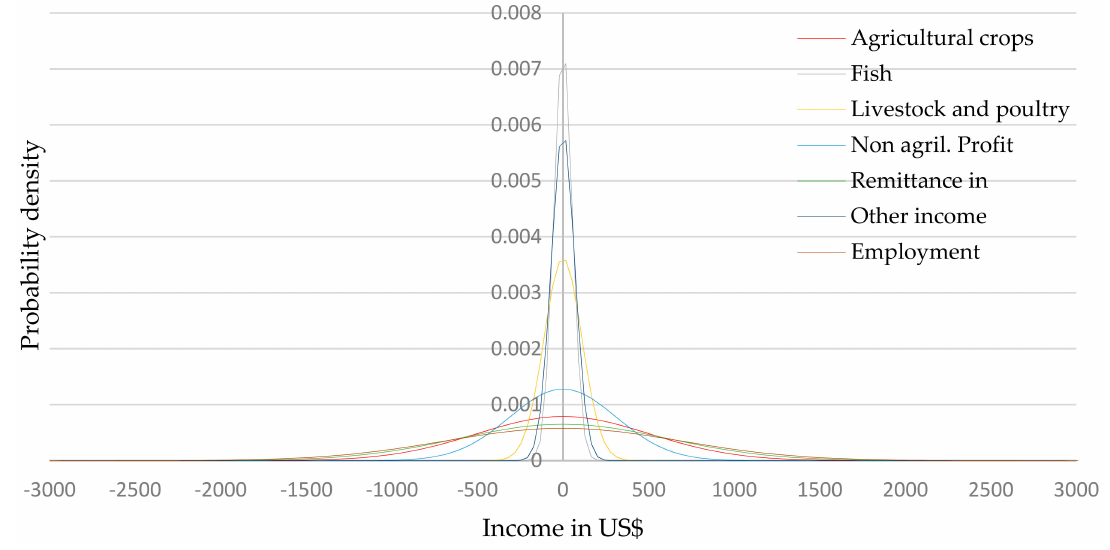
Figure 6. Distribution of total income (US$) for farm households in Rangpur by income sources.